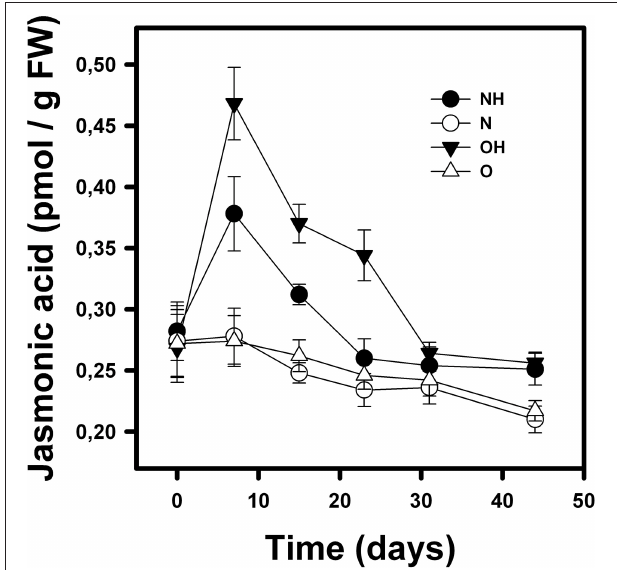
FIGURE 4 | Mean ( ± 1 SD) of jasmonic acid concentration (pmol/gPF) in B. fimbriata rosettes under the four treatments in the greenhouse: nurse-like conditions with (NH) and without (N) herbivory, and open spaces conditions with (OH) and without (O) herbivory.